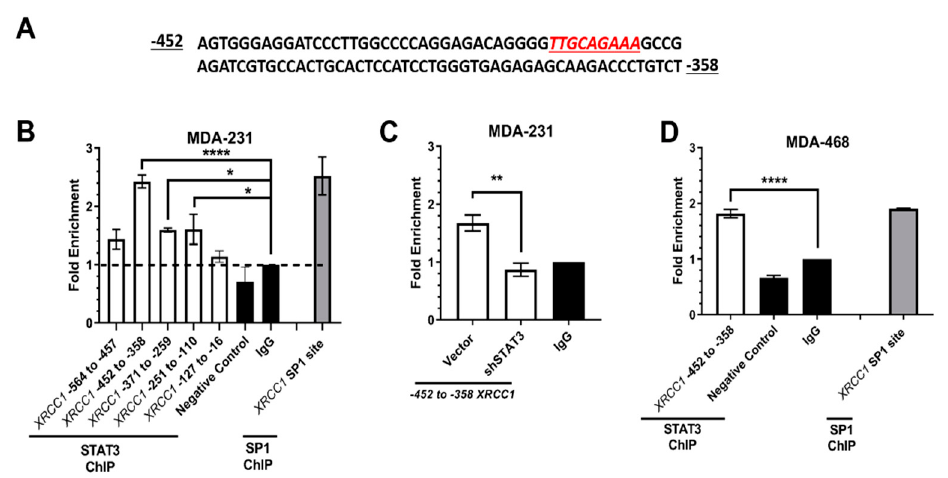
Figure 2. The XRCC1 promoter contains a STAT3 binding site. ( A ) CiiiDER identified an STAT3 binding sequence within the XRCC1 promoter (red font). ( B ) ChIP analysis of XRCC1 promoter in MDA-231 cells show a significant enrichment of STAT3 between -452 and -358. ( C ) The knockdown of STAT3 with shRNA #1 eliminates STAT3 binding within the -452 to -358 fragment. CHiP using primers specific for the SP1 binding site within the XRCC1 promoter was performed as a positive control. ( D ) STAT3 binding also occurs within the -452 to -358 fragment of the XRCC1 promoter in MDA-468 cells. * p < 0.05 ** p < 0.01, **** p < 0.0001.